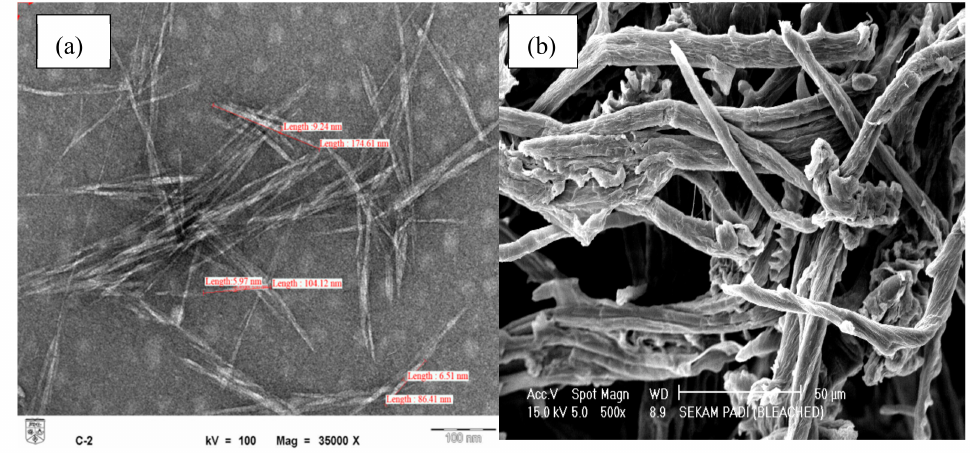
Figure 1. ( a ) Transmission electron microscopy (TEM) image of cellulose nanocrystals (CNCs) and ( b ) scanning electron microscopy (SEM) image of microcellulose